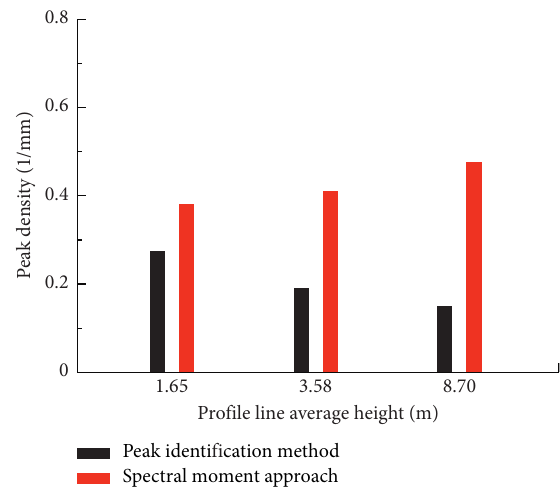
Figure 5: Peak density for the three joint profiles.